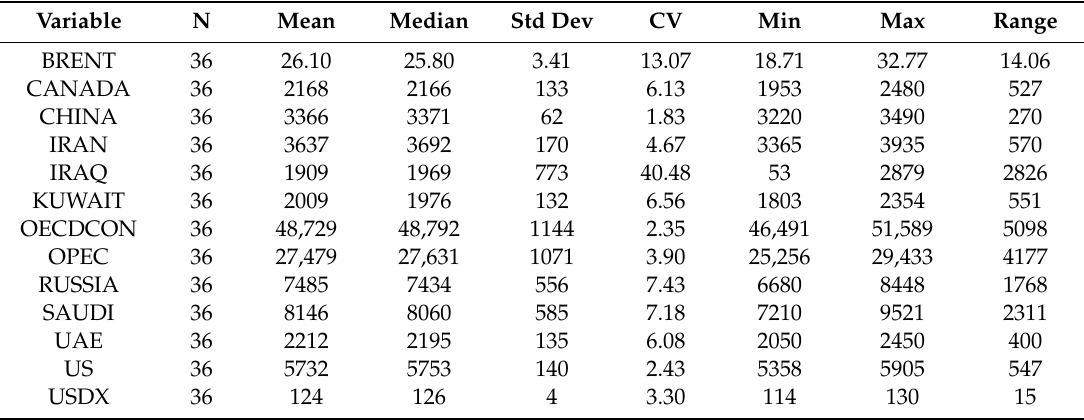
Table 7. Panel 2 period (2001–2003): summary statistics.